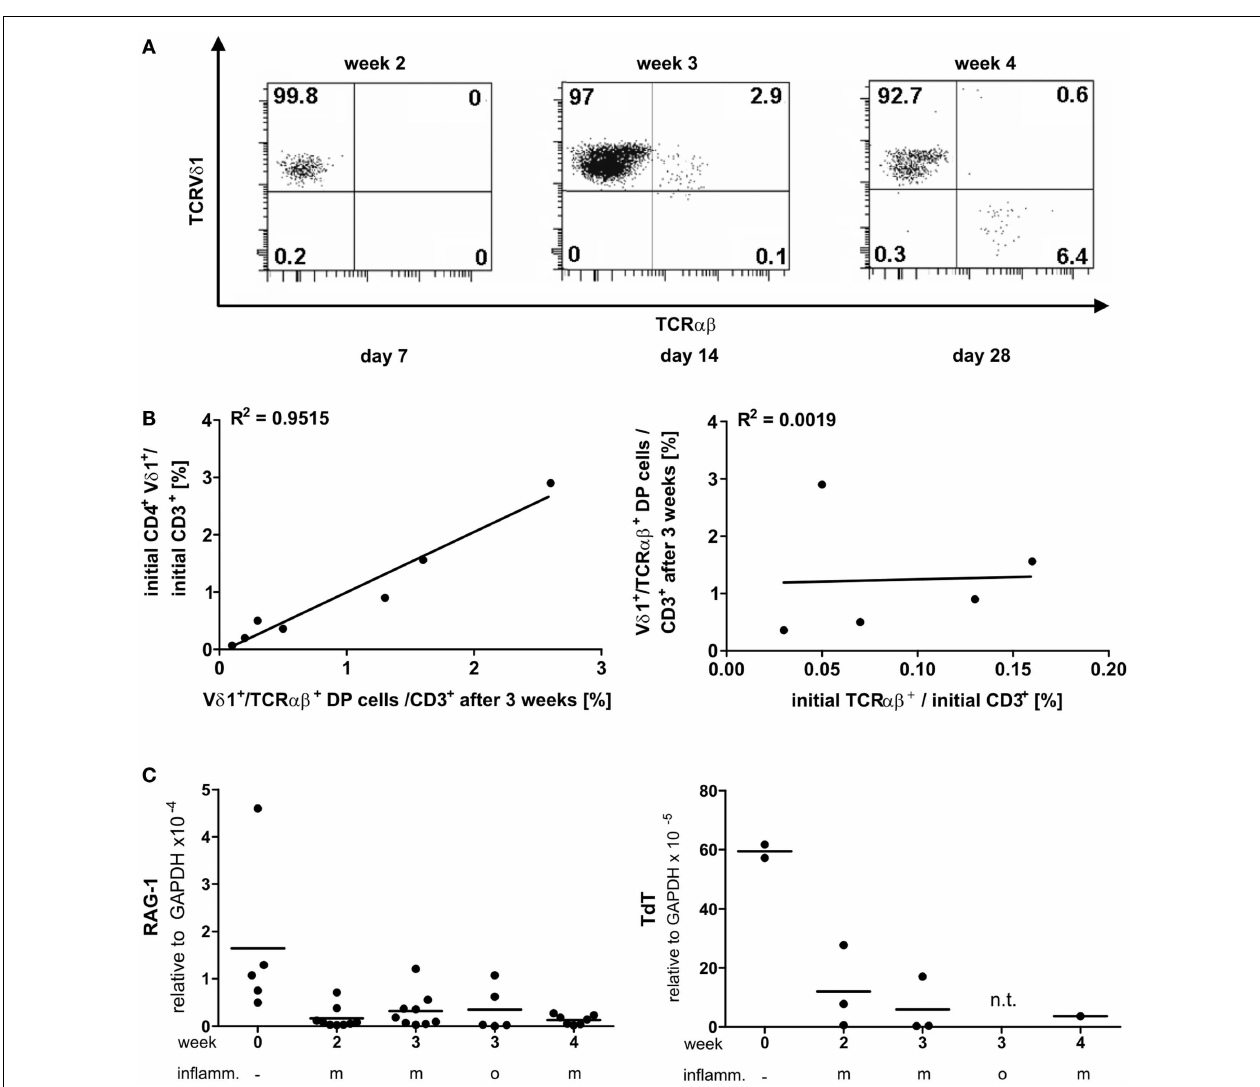
CD4 + V δ 1 + T cells in initialV δ 1 + T-cell pool (left).There was no correlation between residualTCR- αβ + T cells afterV δ 1 + cell separation and set-up of initial V δ 1 + T-cell culture and the number ofV δ 1 + /TCR- αβ + double-positiveT cells after 3weeks of culture (right). Each dot represents one independent experiment. (C) After initial depression, RAG-1 andTdT quantities subtly increased inV δ 1 + cell cultures and were detectable simultaneously with the appearance ofV δ 1 + /TCR- αβ + coexpressing cells. m, Mild inflammation (IL-7, PHA, IL-2, and irradiated allogeneic feeder cells); o, overt inflammation (exposure to strong inflammatory stimuli in week 3, conditions described in the Section “Materials and Methods”); week 0, freshly isolated, nativeV δ 1 + cells were analyzed.